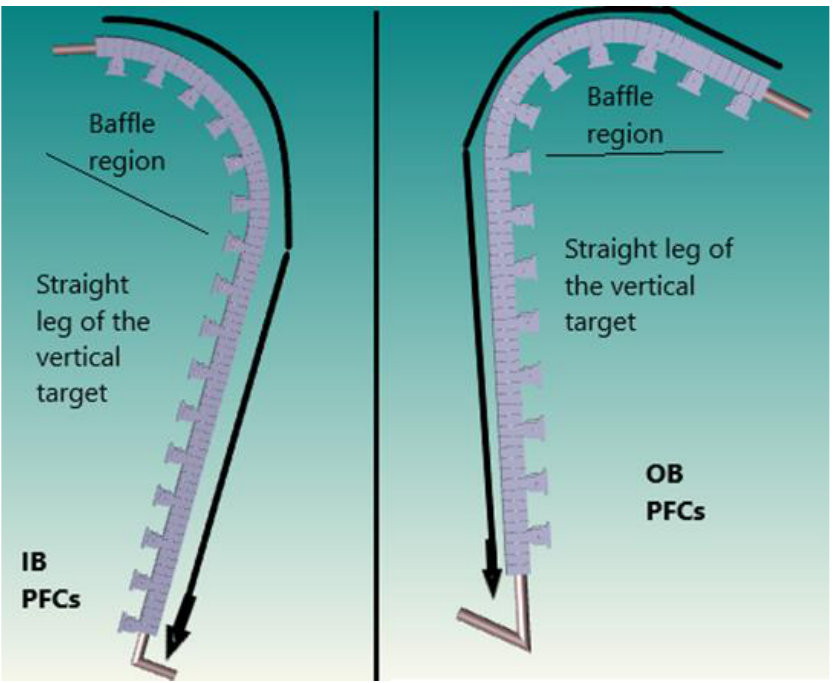
Figure 10. Inboard and outboard poloidal profiles of the PFCs, in which is highlighted the curvilinear abscissa used in the 2D plots, which originates in the upper part of the target directing downwards, towards the profiles.